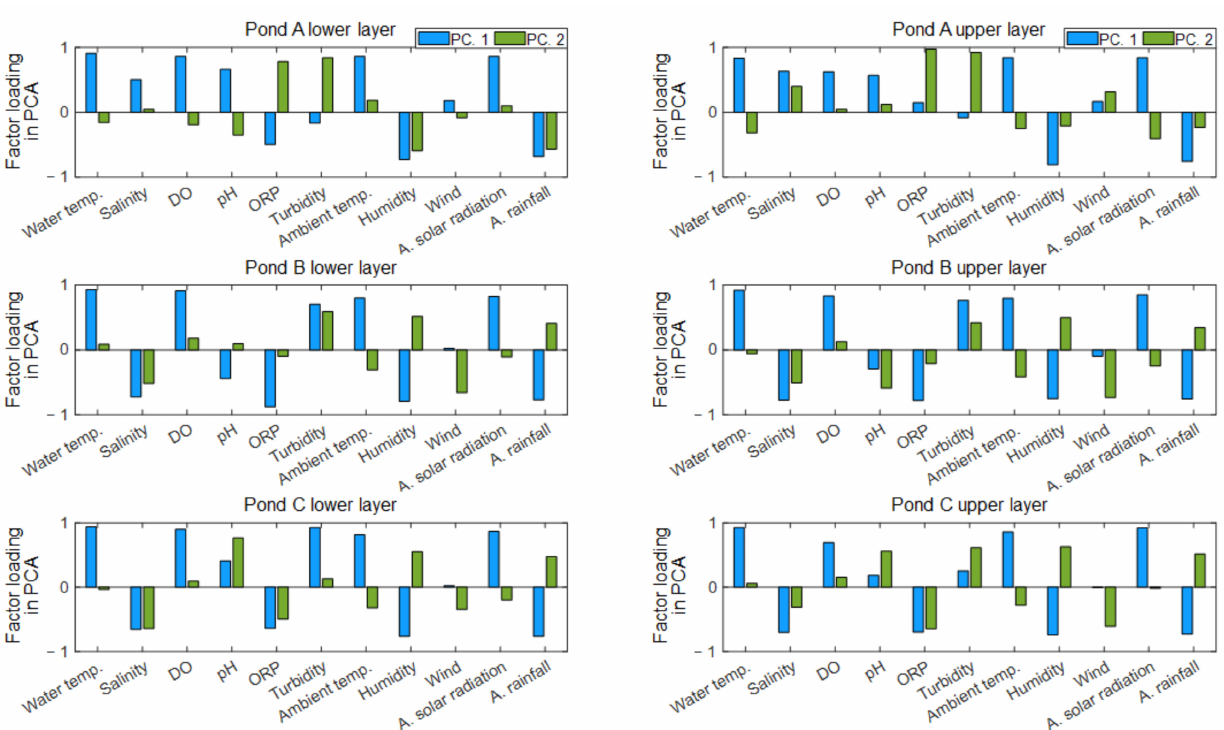
Figure 13. Factor loading by 1st and 2nd PCs for the heat storage